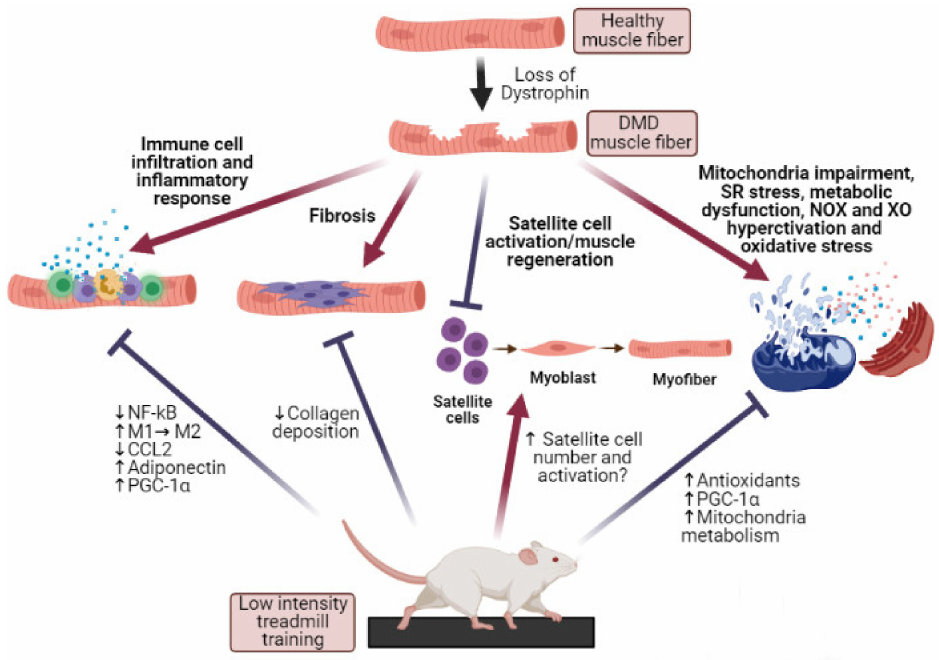
Figure 2. Effects of low intensity treadmill running on mdx muscle pathological changes. Exercise can reverse: (a) Inflammatory response, by inducing a shift of macrophage population from to M1 pro-inflammatory type to the regenerative M2 type, and by modulating inflammatory pathways and molecules, including NF-kB (Nuclear factor-kB), CCL2 (Monocyte chemoattractant protein-1), Adiponectin and PGC-1 α (Peroxisome proliferator-activated receptor gamma coactivator 1-alpha); (b) Fibrosis, by reducing collagen deposition; (c) Muscle degeneration, likely by activating satellite cells; (d) Oxidative stress and metabolic impairment, and the related mitochondria and SR (sar- coplasmic reticulum) stress, NOX (NADPH oxidase) and XO (xanthine oxidase) hyperactivation, by inducing activation of antioxidants, mitochondria metabolism and PGC-1 α pathway. Created with